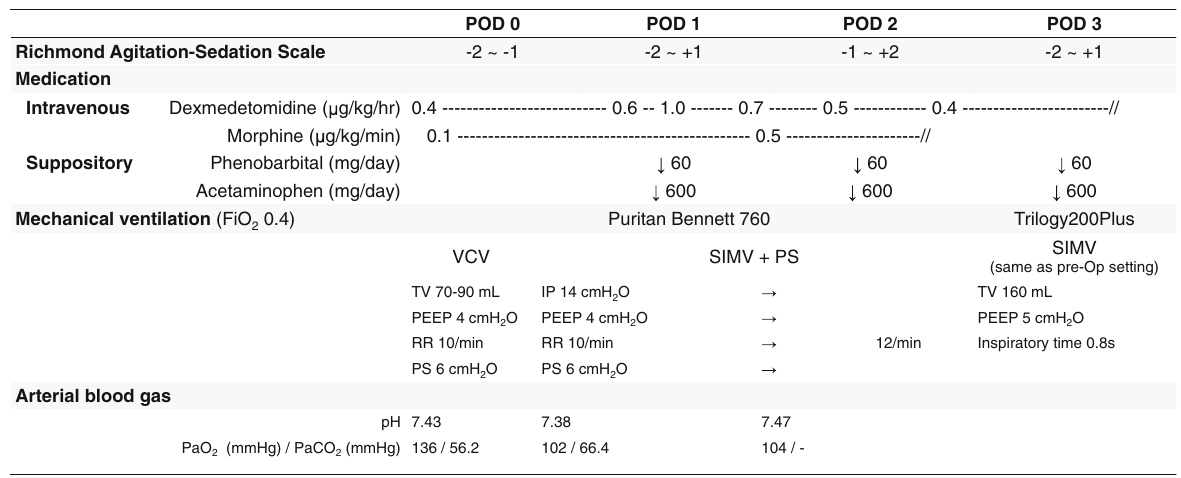
Fig. 1 Post-operative course. Post-operative course of her medication and respiratory